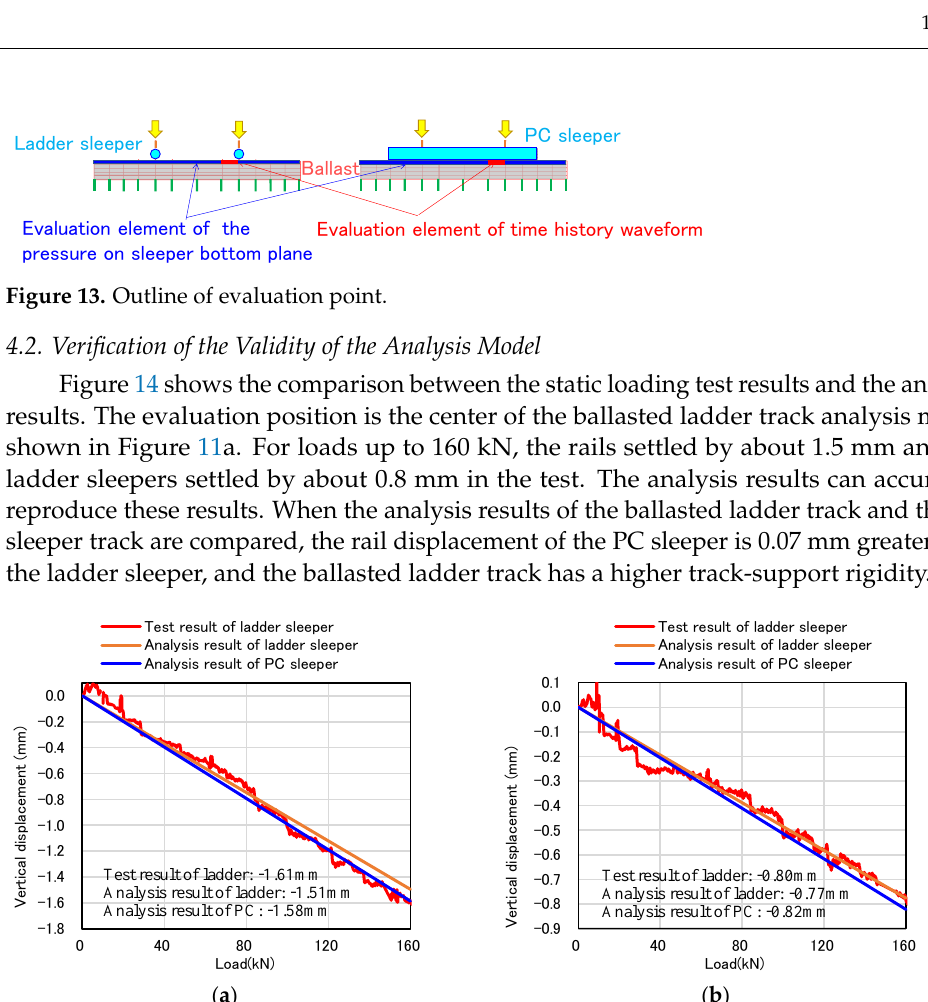
Figure 14. Comparison between the static loading test results and the analysis results: ( a ) rail; ( b ) sleeper.